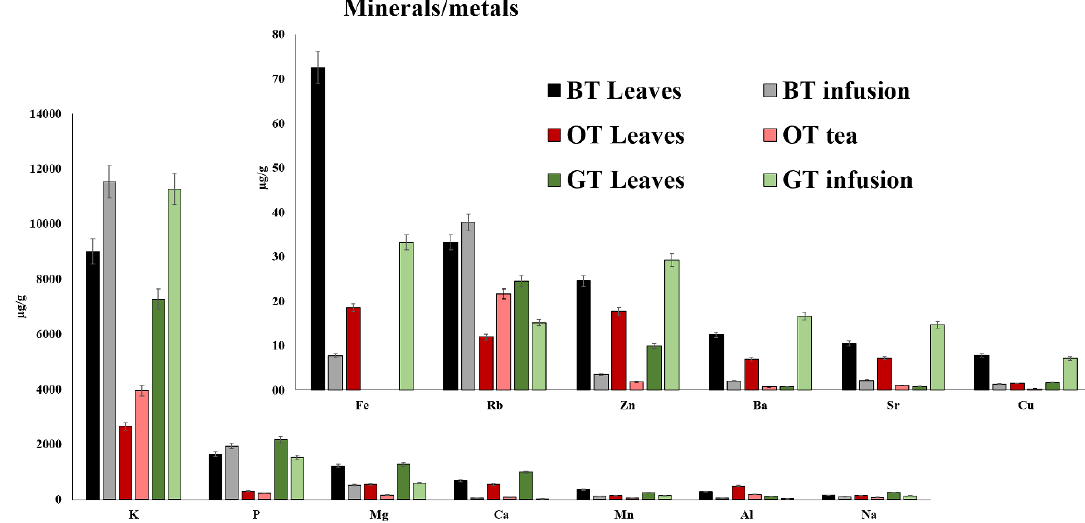
Figure 4. Histogram comparison of mineral and metal concentration in tea leaves and infusions of black tea (BT), blue tea (BT), green tea (GT).